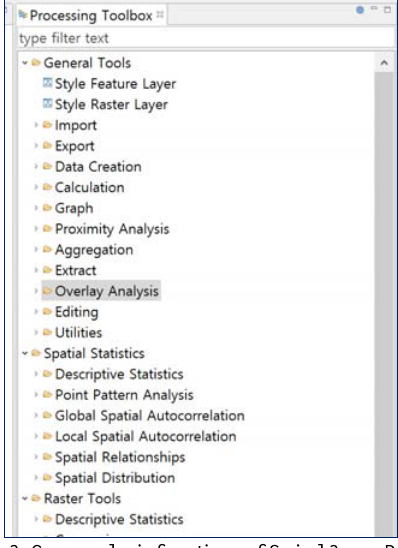
Figure 3. Geo-analysis functions of Spiral 3 on uDig SW